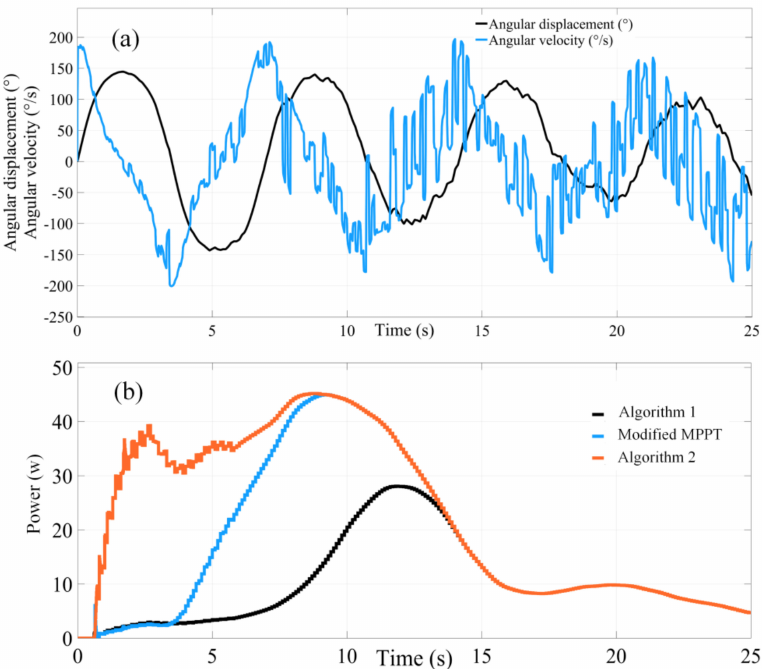
Figure 22. Algorithm comparison of time-varying sea conditions: ( a ) precession angular displacement and angular velocity under irregular sea conditions; ( b ) power output of three